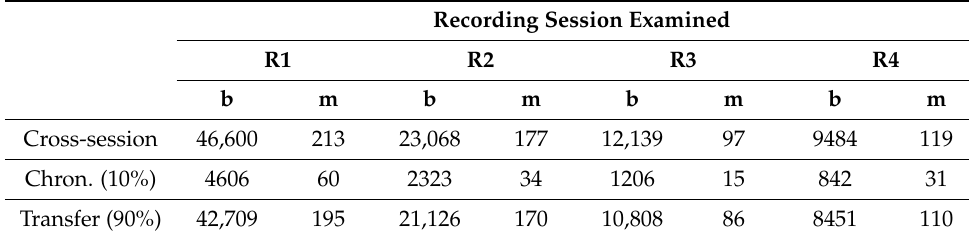
Table 1. Numbers of benign (b) and malicious (m) samples in the plot dropping attack.